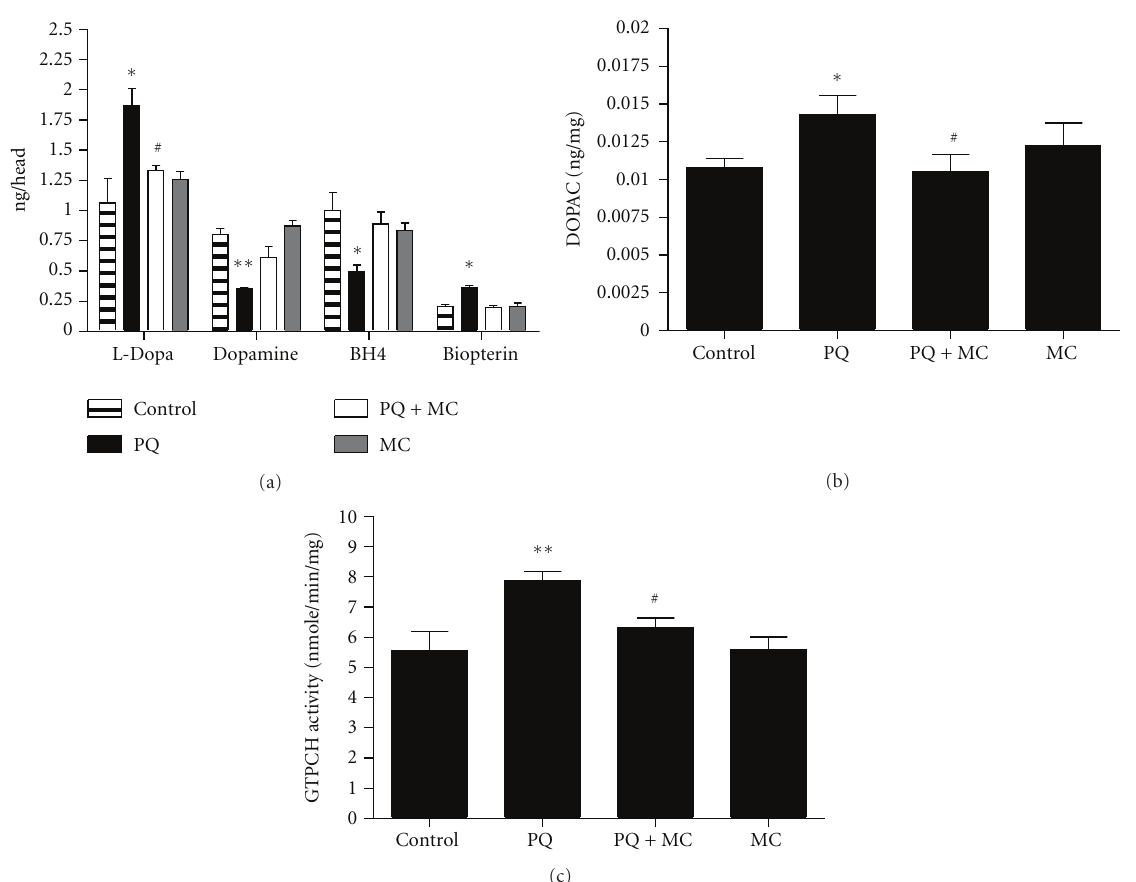
Figure 4: MC blocks the changes induced by PQ in the DA and BH 4 biosynthesis pathways. (a) Changes in the DA and BH 4 metabolites in adult males exposed to 10 mM PQ or 10 mM PQ with 1mM MC for 24 hrs. The increase in L-DOPA levels, indicative of PQ-stimulated TH activity, is reduced by MC. (b) The DA metabolite, DOPAC, is elevated by PQ exposure and is significantly decreased by the co-feeding of MC to male adults for 24hr. (c) The compensatory increase in GTPCH activity in PQ-fed adult males is reduced in PQ-MC co-fed males at 24 hr of ingestion. The significance of di ff erences in each subset between the PQ-treated and control groups, and PQ-treated and co-fed groups is indicated as ∗ and # , respectively, where ∗ and # = P < 0 . 05 and ∗∗ and ## = P < 0 . 005. Error bars represent the standard error of the mean. Each data point represents at least 10 replications of 15 flies each.